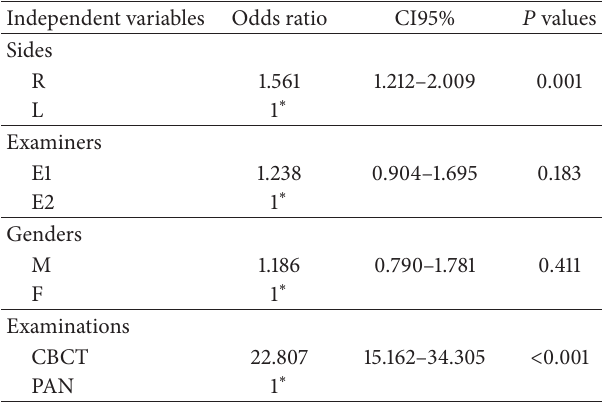
Table3:Influenceofsomevariablesontheprobabilityofidentifying the mandible incisive canal [MIC] as calculated by the GEE